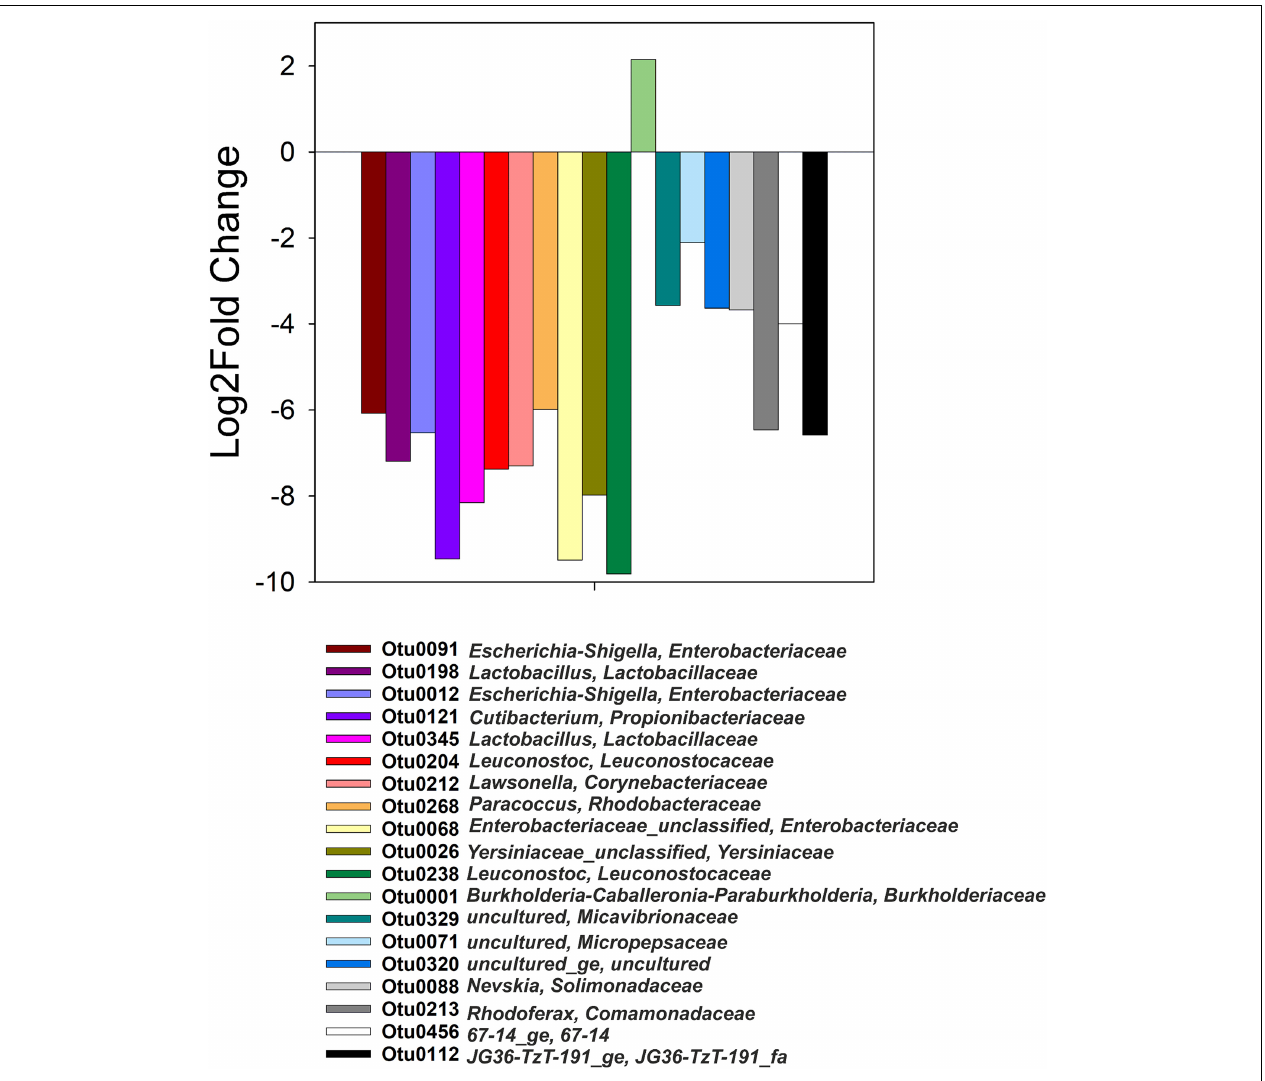
FIGURE 4 | Genus-level taxa with significantly different relative abundances ( p < 0.05) in heavy and light fractions of 13 C-acetate treatments only, i.e., such taxa were not differentially abundant in heavy than light fractions at t 0 or 12 C-acetate